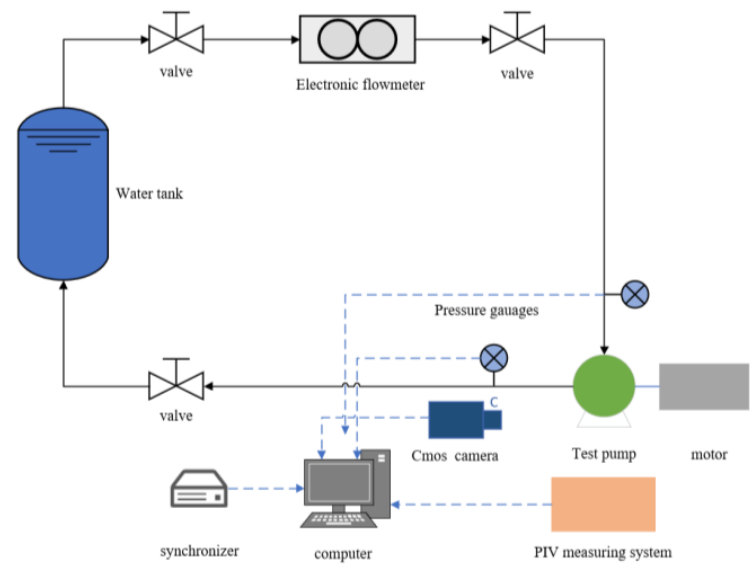
Figure 2. Schematic of the PIV test rig.